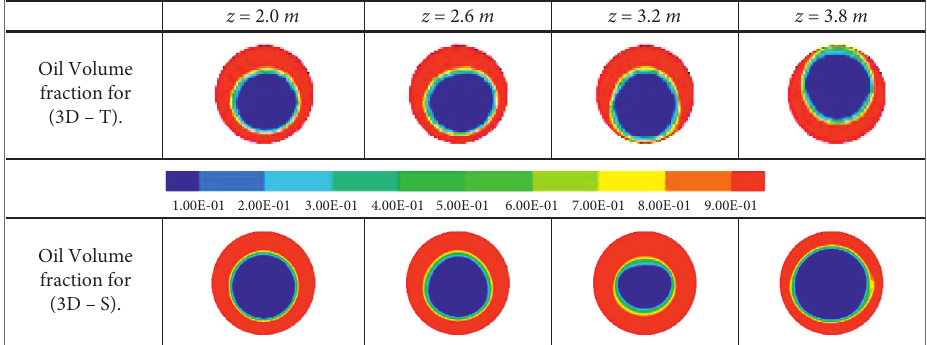
Oil Volume fraction for (3D – T).